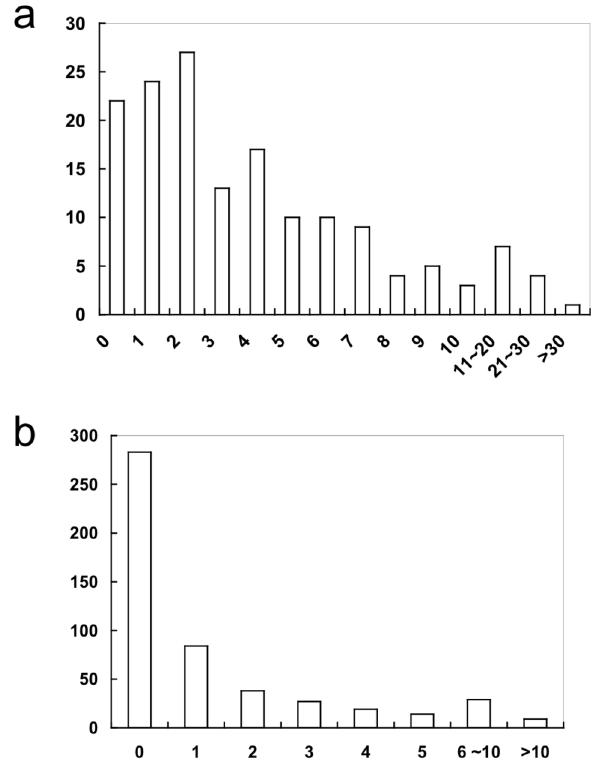
Figure 4. Substitutions introduced in output sequences of the 155 retrospective samples. a, Distribution of the number of different types of substitutions judged as mutations per sample. Horizontal axis, number of the types of substitutions; vertical axis, number of samples. b, Distribution of the number of samples with a substitution type judged as a mutation. Horizontal axis, the number of samples with a substitution type judged as a mutation; vertical axis, number of the types of substitutions. doi: